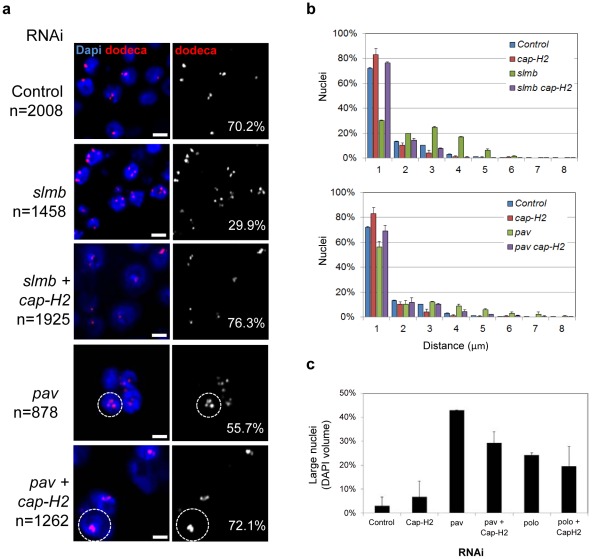
RNAi of a subset of pairing promoters causes Cap-H2–dependent pairing disruption.a, Representative FISH images are shown for RNAi knockdown of candidate pairing promoters slmb and pav, where the number of single-signal dodeca FISH signals per nucleus (noted) is decreased as compared to lacZ RNAi control (P<0.05). Co-depletion of Cap-H2 increases the number of single-signal dodeca FISH signals per nucleus (P<0.05 compared to slmb and pav RNAi alone). pav RNAi also produces multi-nucleated cells and large nuclei (hashed circles), characteristic of cytokinesis defects that lead to aneuploidy, which are also observed following pav cap-H2 double RNAi treatment. n denotes number of nuclei scored. Scale bars equal 5 µm. Also see Table 1. b, Relative frequencies of interhomolog distances (unpaired = two signals >1.0 µm apart) based on dodeca FISH ± SD for three tests. Cap-H2 co-depletion also reduces the distances between signals following slmb and pav RNAi (P<0.05), another indication that pairing is restored. c, The percentage of large nuclei ± SD following pav and polo RNAi in the presence and absence of cap-H2 RNAi. Although the frequency of large nuclei in pav cap-H2 is significantly reduced as compared to that of pav (P = 0.0072), both were significantly increased compared to controls (P<0.0001). The frequency of large nuclei in polo cap-H2 was not significantly different as compared to that of polo (P = 0.3791). A minimum number of 500 nuclei were scored for each experiment.